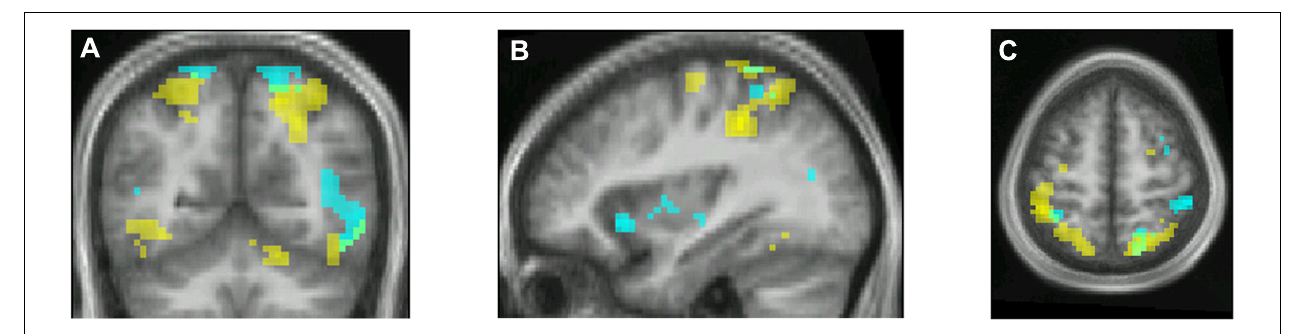
FIGURE 5 | Overlaid contrasts showing conjunction of activity produced by the contrasts color grouping > no grouping (yellow) and motion grouping > no grouping (cyan) as seen in coronal (A), parasagittal (B) and horizontal (C) sections through the brain . From Zeki and Stutters (2013).